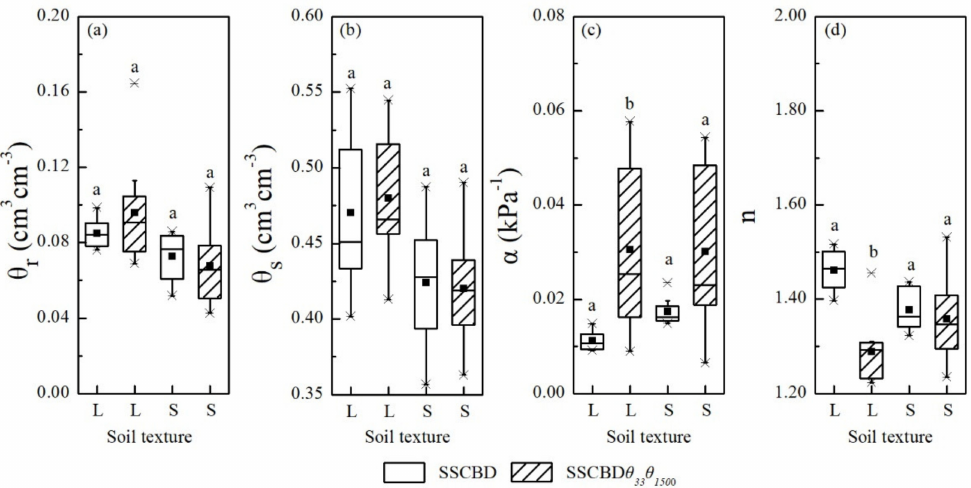
Figure 4. Comparison of the VG model parameters obtained using the Rosetta model with inputs of SSCBD and SSCBD θ 33 θ 1500 , respectively, for the lightly (L) and severely (S) eroded soil degrees. ( a – d ) is the residual water content ( θ r ), saturated water content ( θ s ), scale parameter ( α ), and shape parameter ( n ), respectively. Di ff erent letters indicate significant di ff erences at p = 0.05 between output parameters using two inputs (SSCBD and SSCBD θ 33 θ 1500 ) at the p = 0.05 significance level with the t